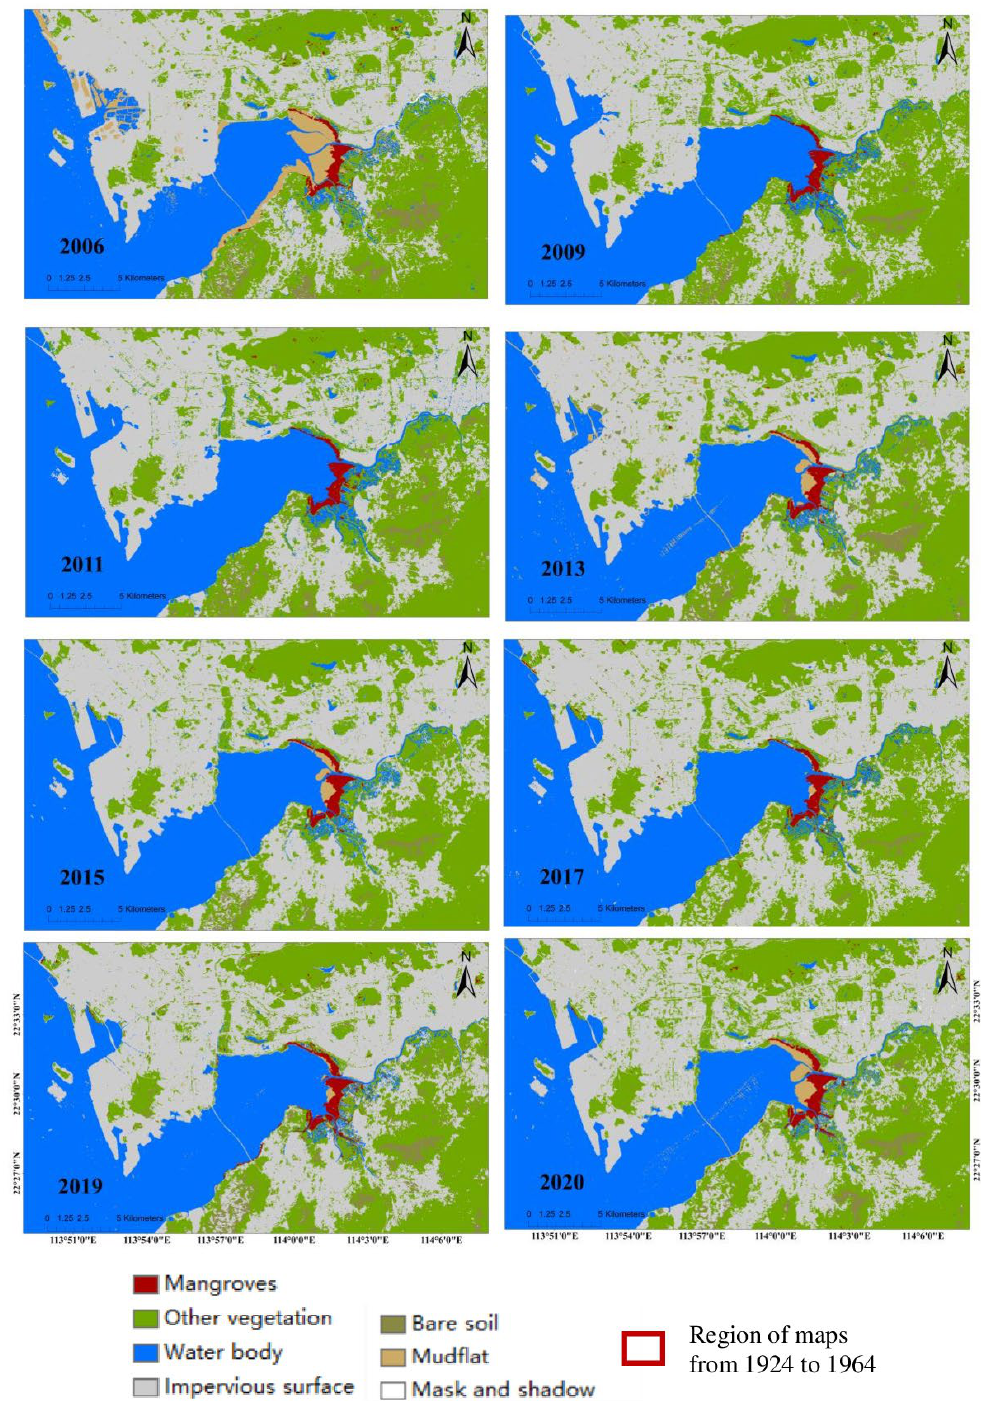
Figure 5. Landsat image mapping results from 1987 to 2020.